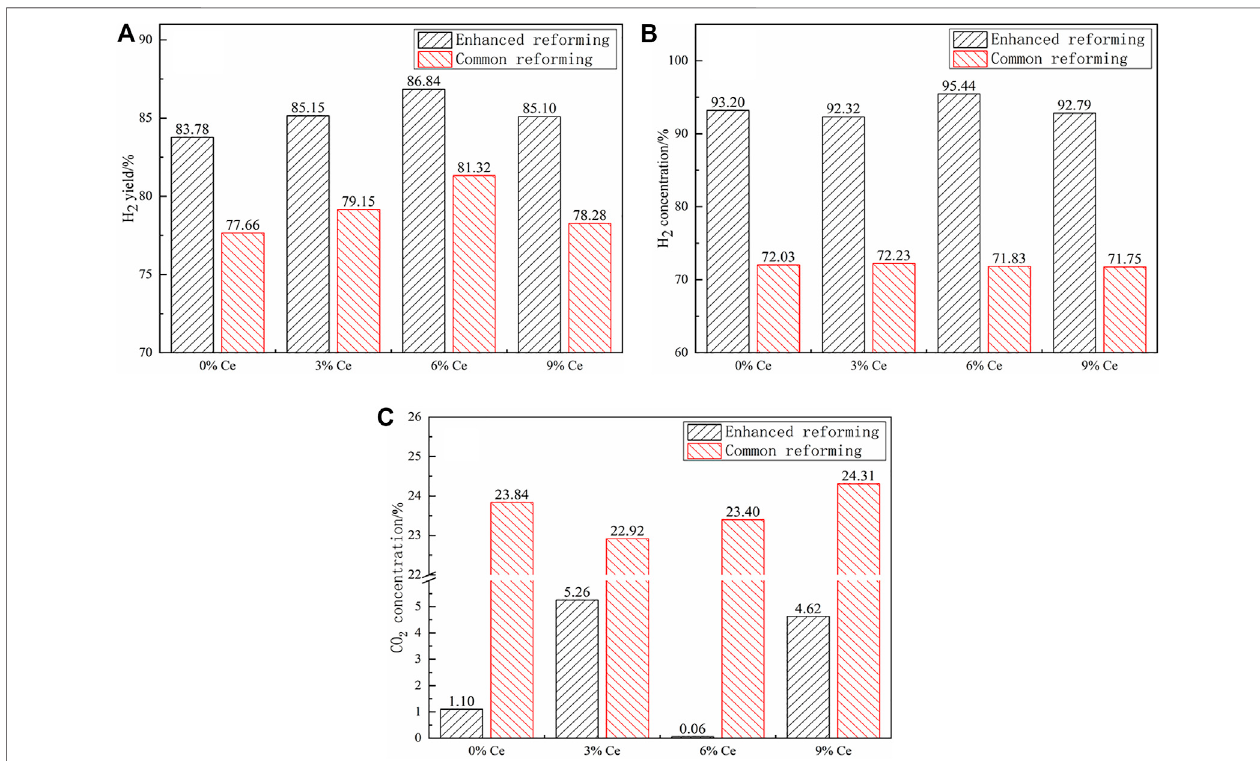
FIGURE 5 | Effect of the Ce-modi fi ed catalysts: (A) H 2 yield, (B) H 2 concentration, and (C) CO 2 concentration.